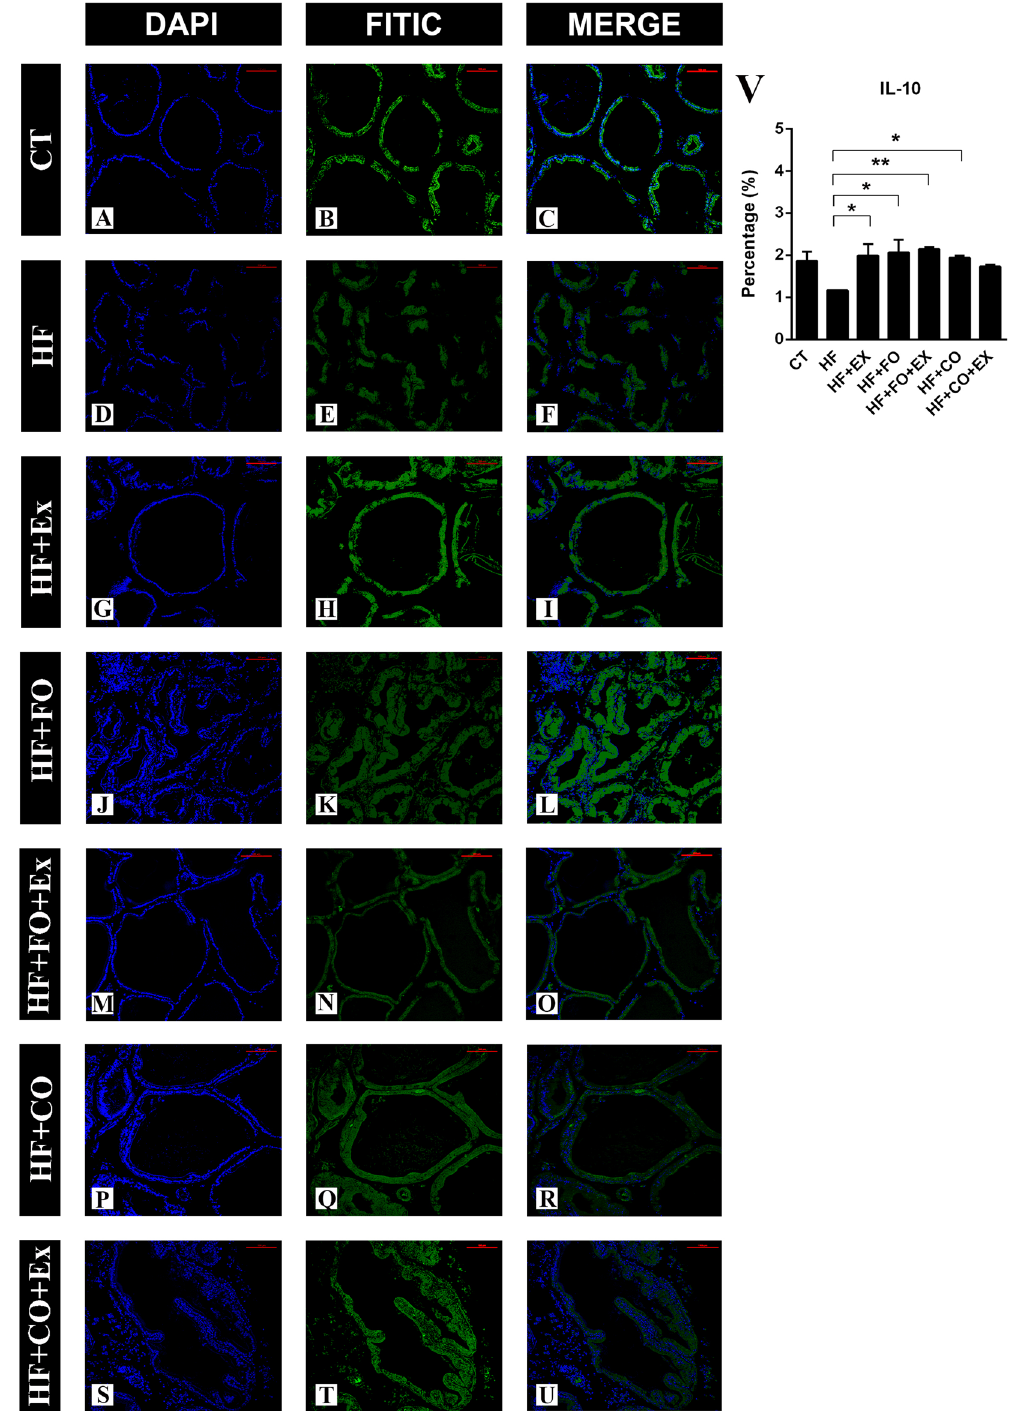
Figure 7. The data are presented as the mean ± SEM (n = 7). The significance of p < 0.05 is indicated by * and p > 0.05 ** indicating a difference between the groups. Immunofluorescence of IL-10 in ventral prostate of animals submitted to high-fat diet, supplemented with ω-3 PUFAs, and performed aerobic physical exercise. ( A ) CT—control; ( B ) HF—high-fat diet; ( C ) HF + Ex—high fat and aerobic exercise; ( D ) HF + FO—high fat and fish oil; ( E ) HF + FO + Ex—high fat, fish oil and aerobic exercise; ( F ) HF + CO—high fat and chia oil; ( G ) HF + CO + Ex—high fat, chia oil and aerobic